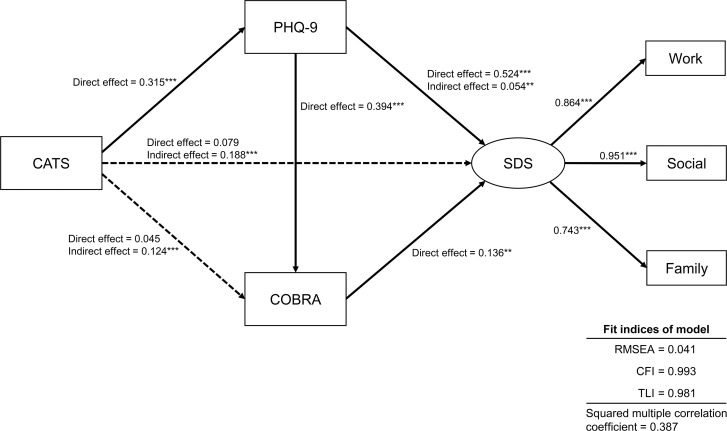
Structural equation model.Abbreviations: CATS = Child Abuse and Trauma Scale, COBRA = Cognitive Complaints in Bipolar Disorder Rating Assessment, PHQ-9 = Patient Health Questionnaire-9, SDS = Sheehan Disability Scale, Work = SDS work, Social = SDS social, Family = SDS family, RMSEA = root-mean-square error of approximation; CFI = comparative fit index; TLI = Tucker–Lewis index. “SDS” was the latent variable, comprising three observed variables: SDS work, social, and family. The numbers next to the arrows show the standardized path coefficients (minimum −1, maximum 1). The rectangles represent the observed variables, and the oval shows the latent variable. The solid lines indicate statistically significant paths, and the broken line indicates the non-significant path. *p < 0.05, **p < 0.01, ***p < 0.001 (two-sided).